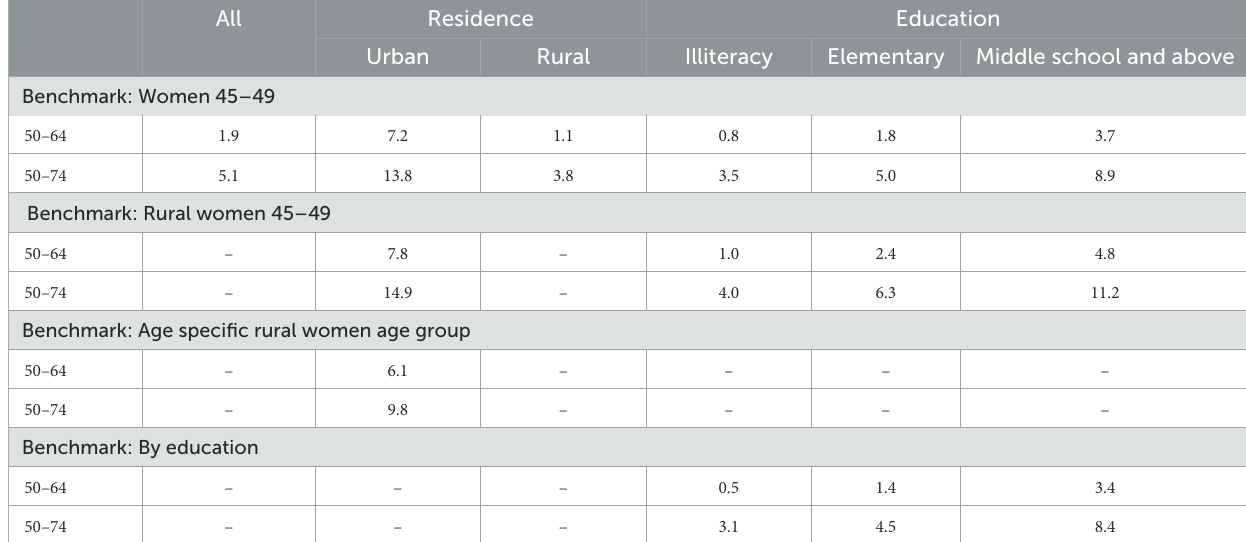
TABLE 7 Years of excess work for women